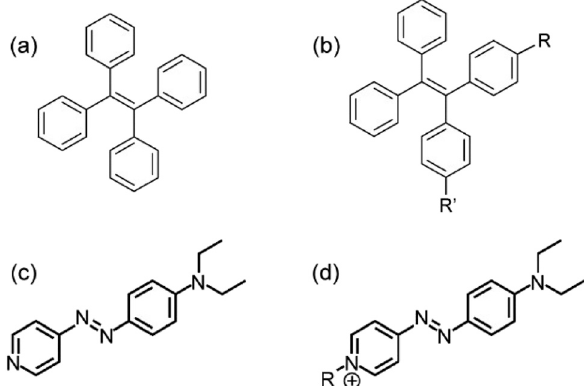
Figure 5: Chemical structures of commonly used organic small molecules. (a) TPE and (b) TPE with common sites for modification indicated by R and R ′ . (c) DASP and (d) DASP with common sites for modification indicated by